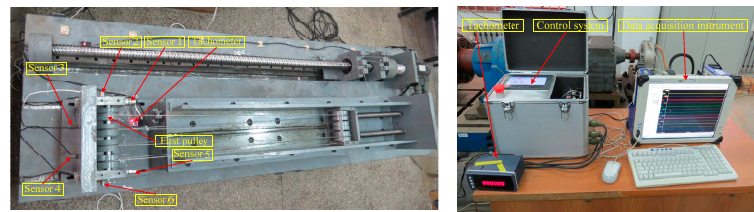
Figure 4. The test rig system of the Pulley group. Table 1. Parameters of angular contact ball bearing in the test.